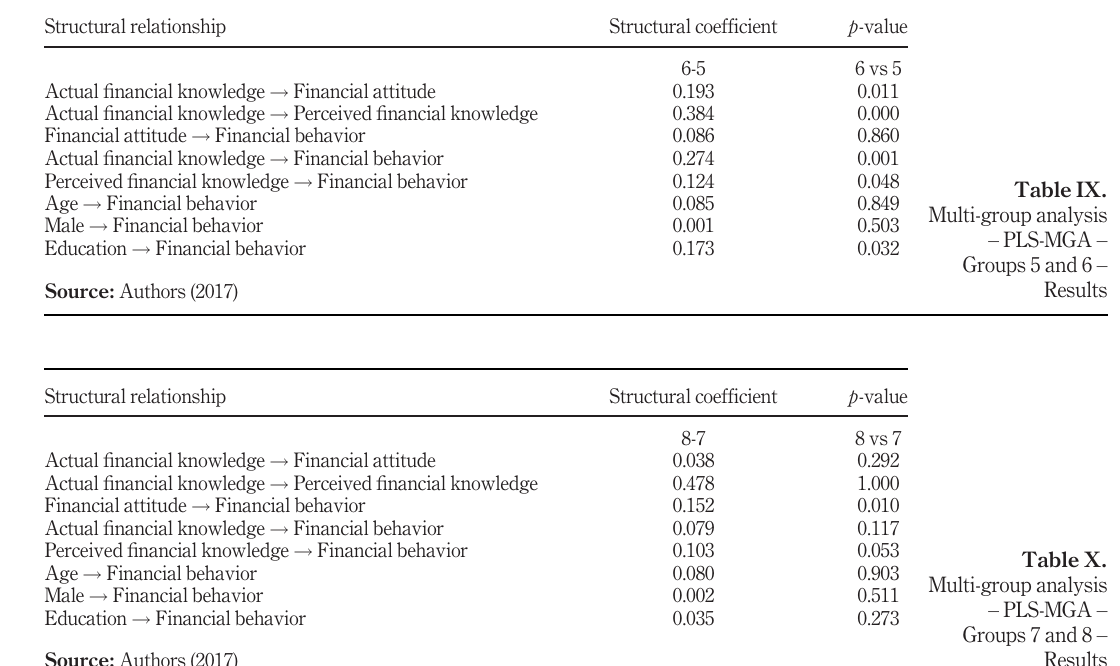
Table X. Multi-group analysis